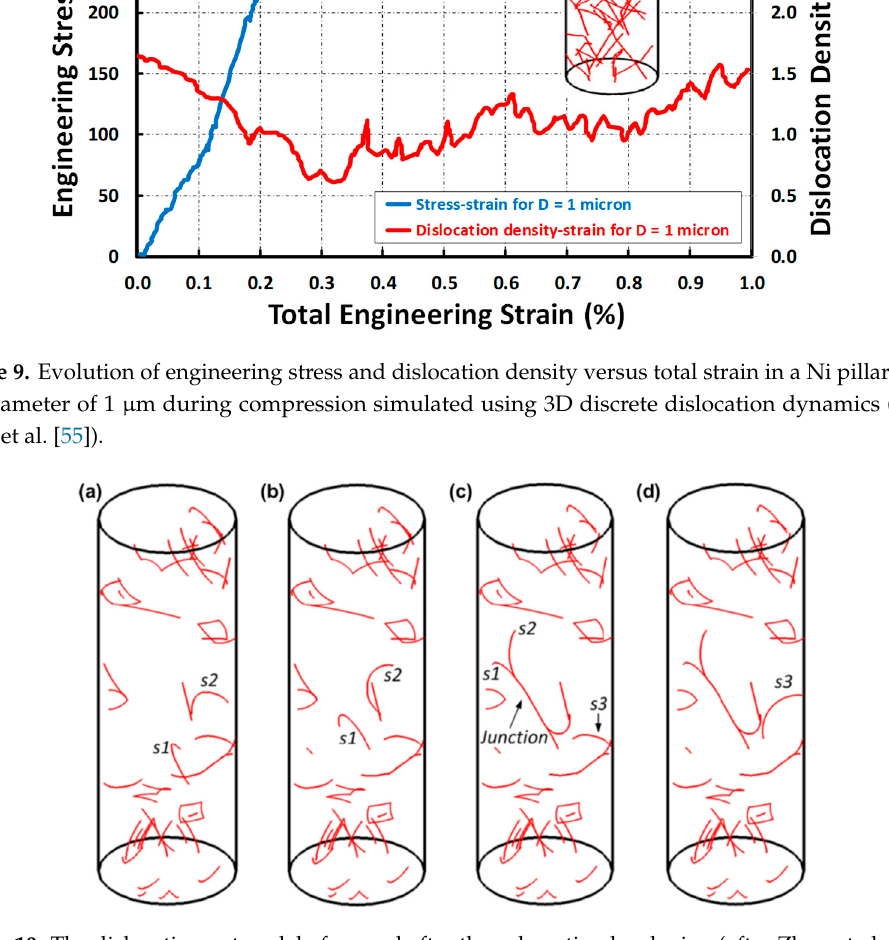
Figure 10. The dislocation network before and after the exhaustion hardening (after Zhou et al. [55]).